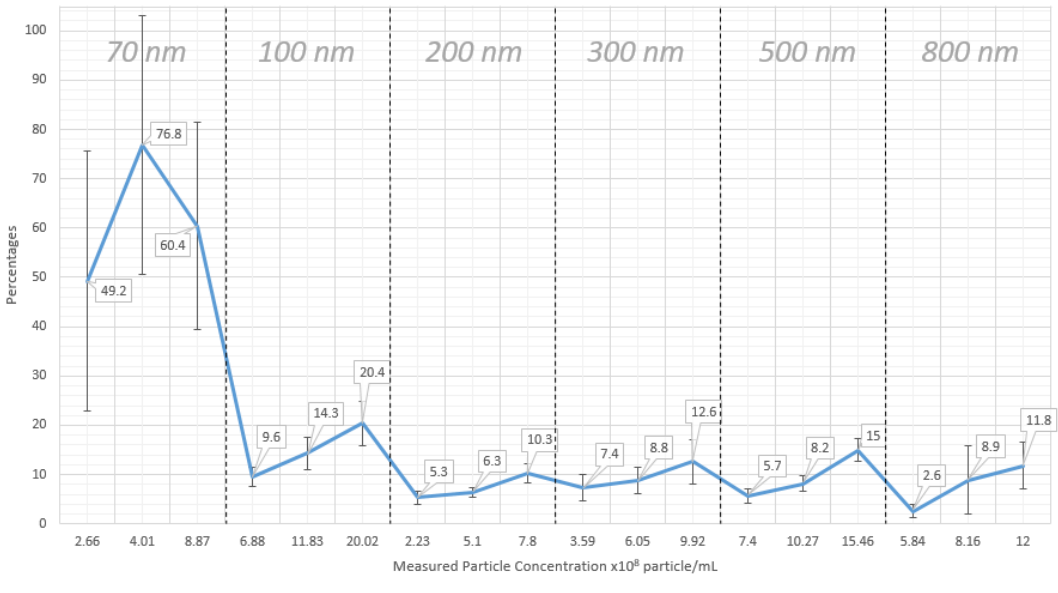
Figure 6. Correction percentages to match prepared concentrations for different silica nanoparticle sizes and for three different concentrations with correction percentages in data labels for each point. Each point in this graph is the average correction percentage for nine separate measurements of the same